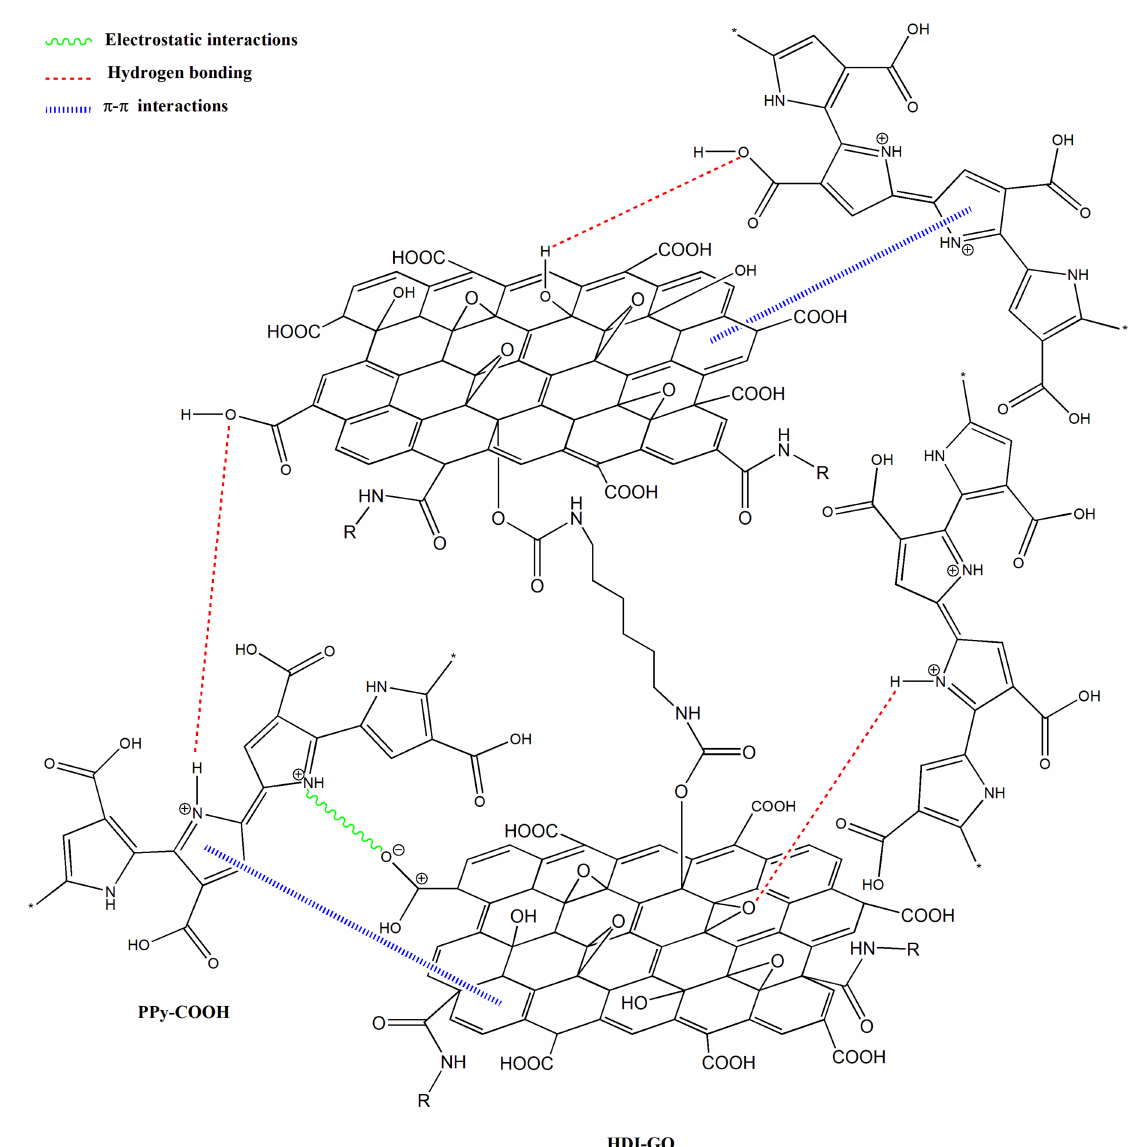
Scheme 3. Representation of the non-covalent interactions between the bipolaron structure of PPy-COOH and